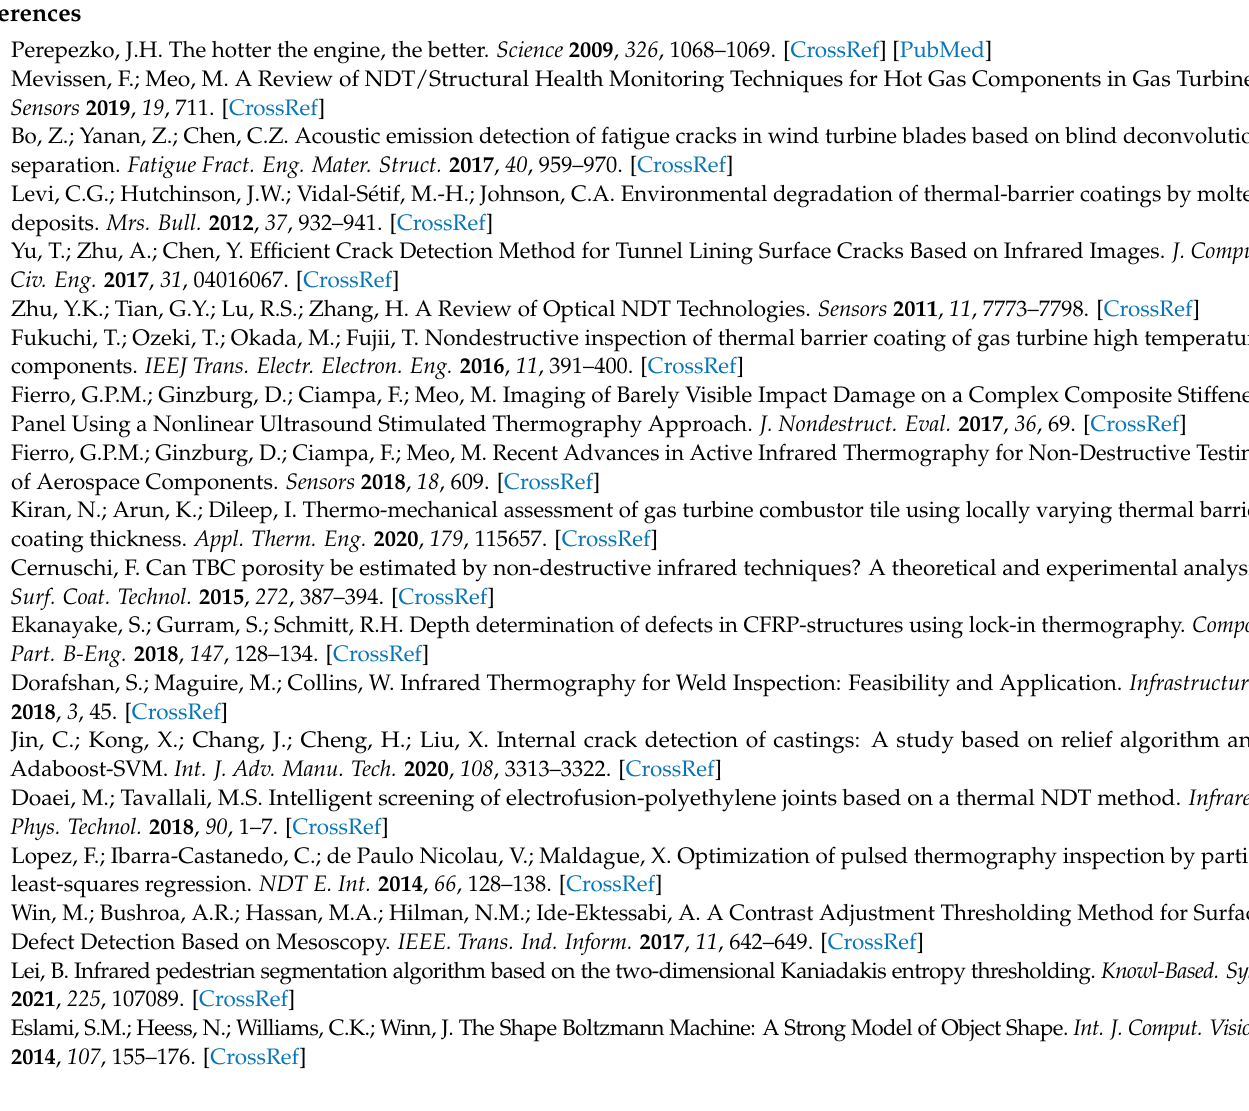
Figure A3. The pore size distributions of the top coat prepared using SEM vs. its numerical recon- structed model.